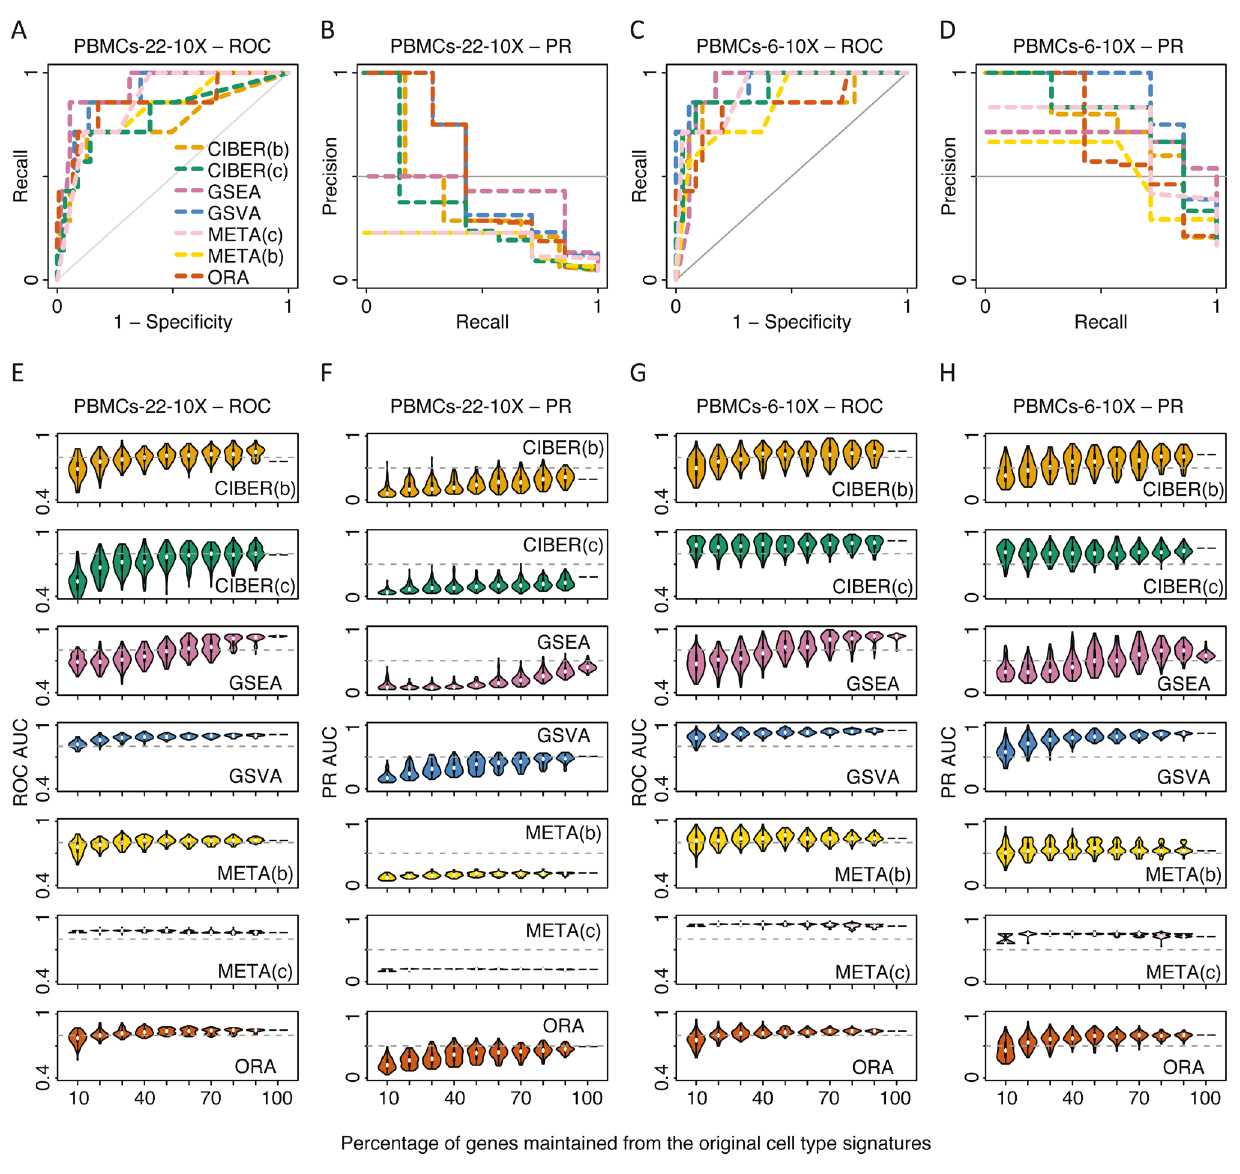
Figure 4. Performance and robustness analysis of cell type prediction methods using 10X PBMCs scRNA-seq data. The same procedure as described in Figure 2 for ROC and PR AUCs of the liver and retinal neuron datasets was used here for the PBMCs dataset measured with the 10X Chromium technology. Please see Figure 2 legend for details. Seven cell clusters from the 10X scRNA-seq measurements could be mapped vs. six out of 22 cell types of the PBMC LM22 matrix signatures. This dataset was analysed in two ways. In the first way (‘PBMCs-22-10X’, panels A , B , E and F ), all 22 cell type signatures from the LM22 matrix were used as input for cell type prediction methods. In the second way (‘PBMCs-6-10X’,panels C , D , G and H ), only the six cell types from the LM22 that could be mapped to the seven cell clusters were used as input for cell type prediction methods. For CIBERSORT and METANEIGHBOR, two approaches were used, one with the original LM22 matrix with continuous gene expression values, that we called CIBERSORT ‘continuous’ (CIBER(c)) and METANEIGHBOR ‘continuous’ (META(c)), and another with a thresholded and binarized version of the LM22 matrix, that we called CIBERSORT ‘binary’ (CIBER(b)) and METANEIGHBOR ‘binary’